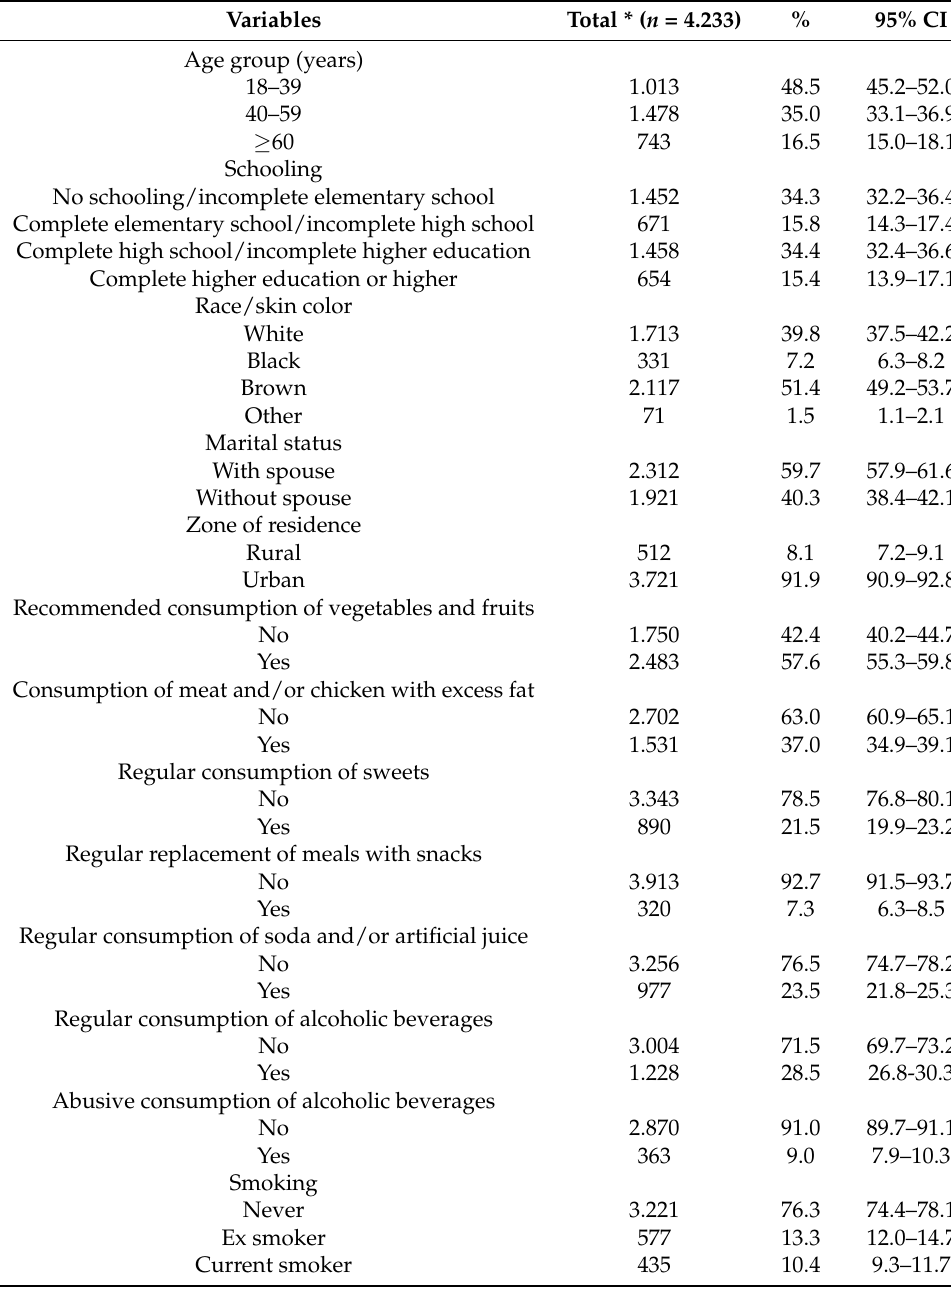
Table 1. Sociodemographic characteristics, lifestyle and multimorbidities in women. Midwest Region, Brazil, National Health Survey,